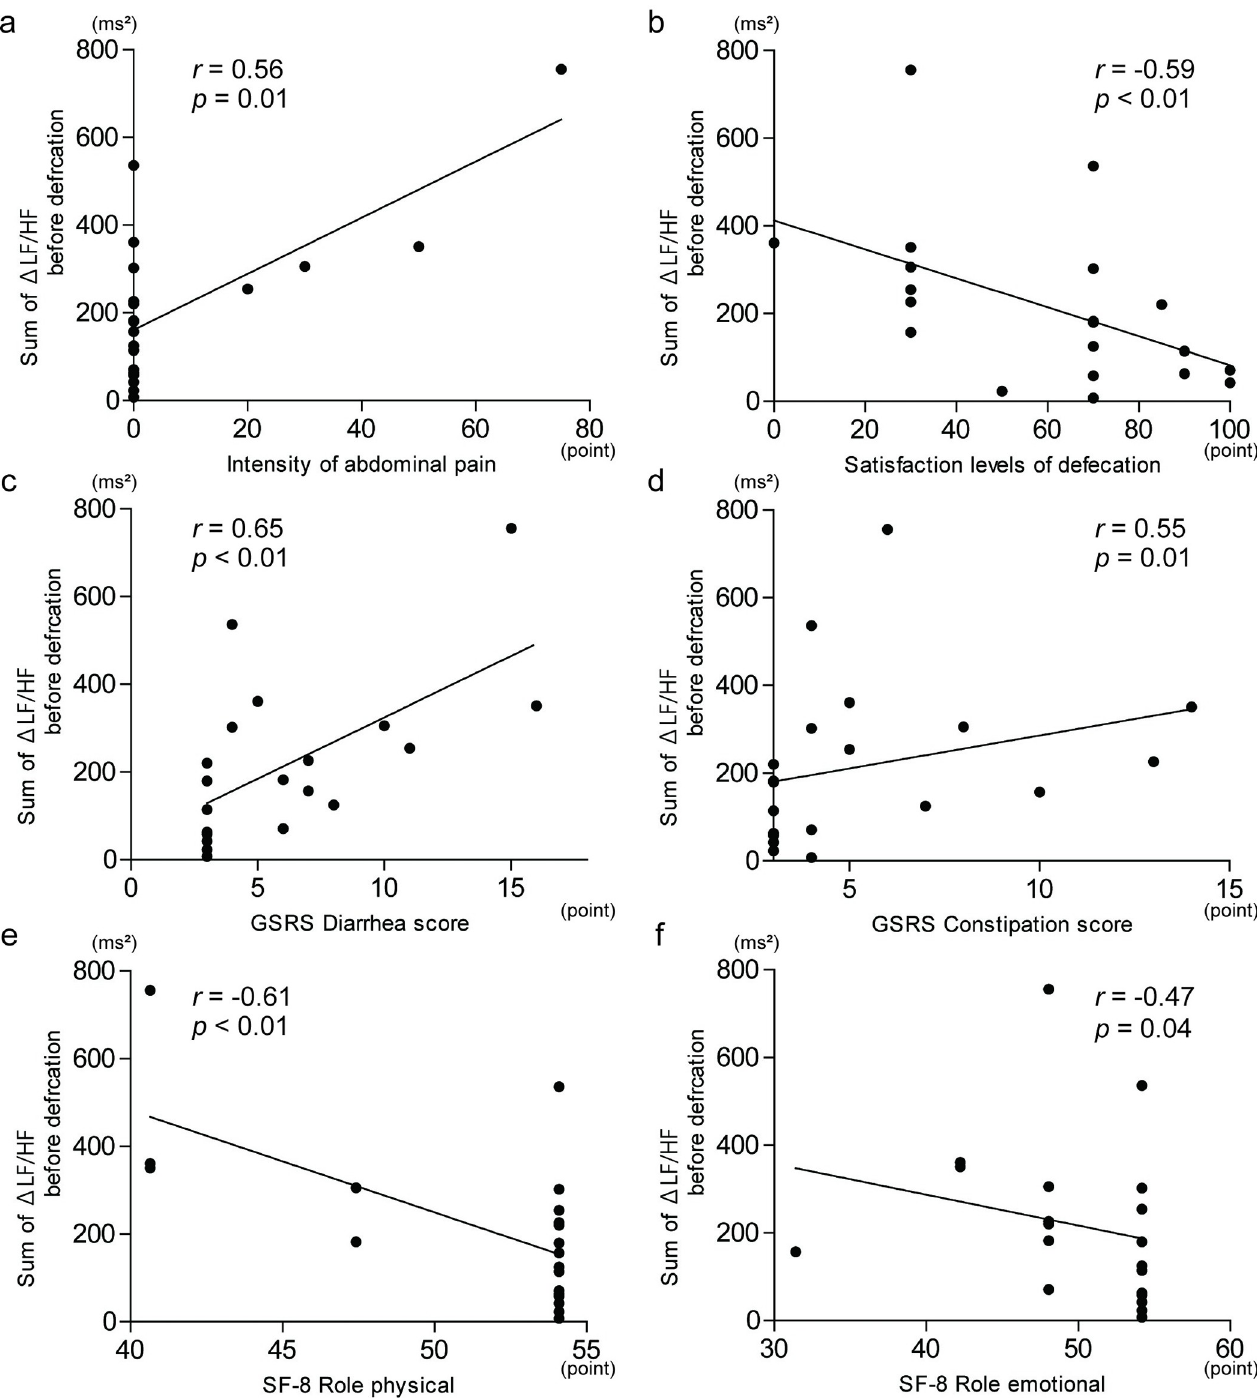
Fig 4. Relationship among sympathetic nerve activity at 2 min before defecation, symptoms, and quality of life. Sympathetic nerve activity was evaluated by the sum of Δ low frequency/high frequency (LF/HF). (a) Intensity of abdominal pain, (b) satisfaction levels of defecation, (c) gastrointestinal symptom rating scale (GSRS) diarrhea score, (d) GSRS constipation score, (e) the Japanese version of the 8-item Short-Form Health Survey (SF-8) role physical, and (f) the SF-8 role emotional score were significantly correlated with the sum of Δ LF/HF at 2 min before defecation. Data were analyzed by Spearman test.